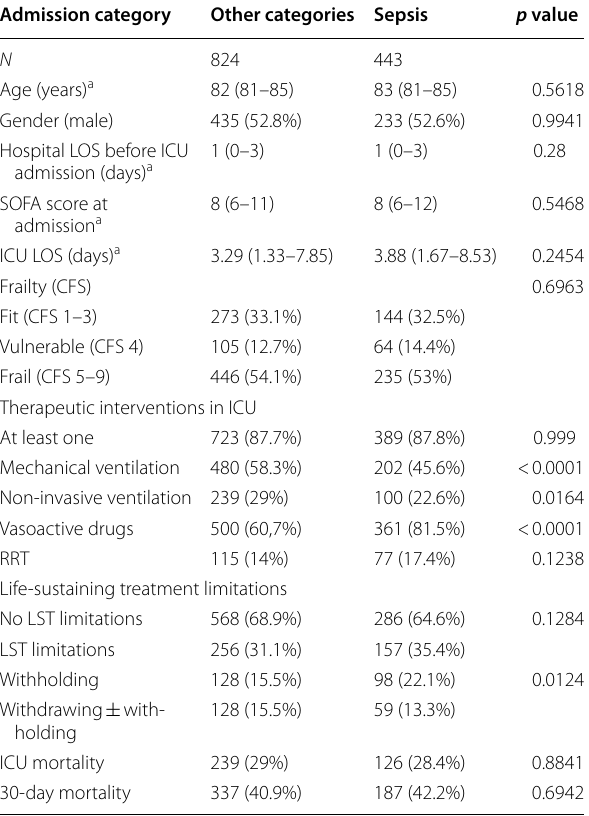
Table 3 Description of the matched